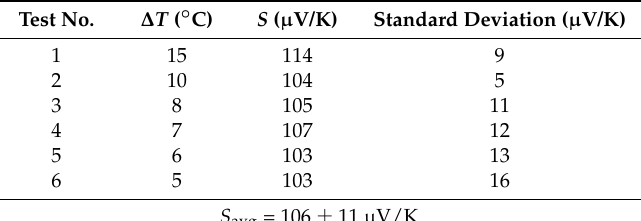
Table 2. Seebeck coefficient of Bi-Te-Ni-Cu-Au thick film measured at various hot-cold end temperature differences. Test No.